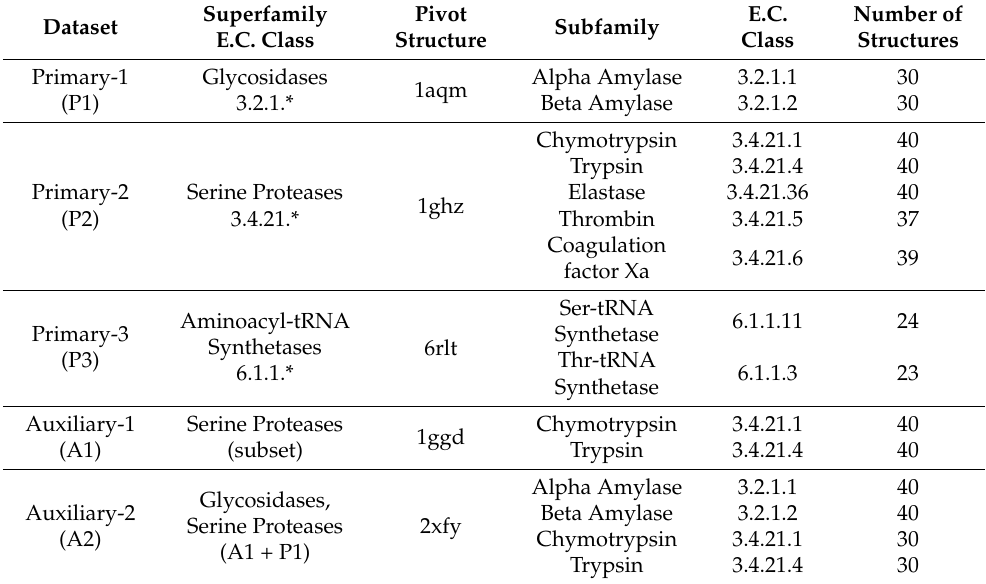
Table 1. Primary and Auxiliary data sets used in this